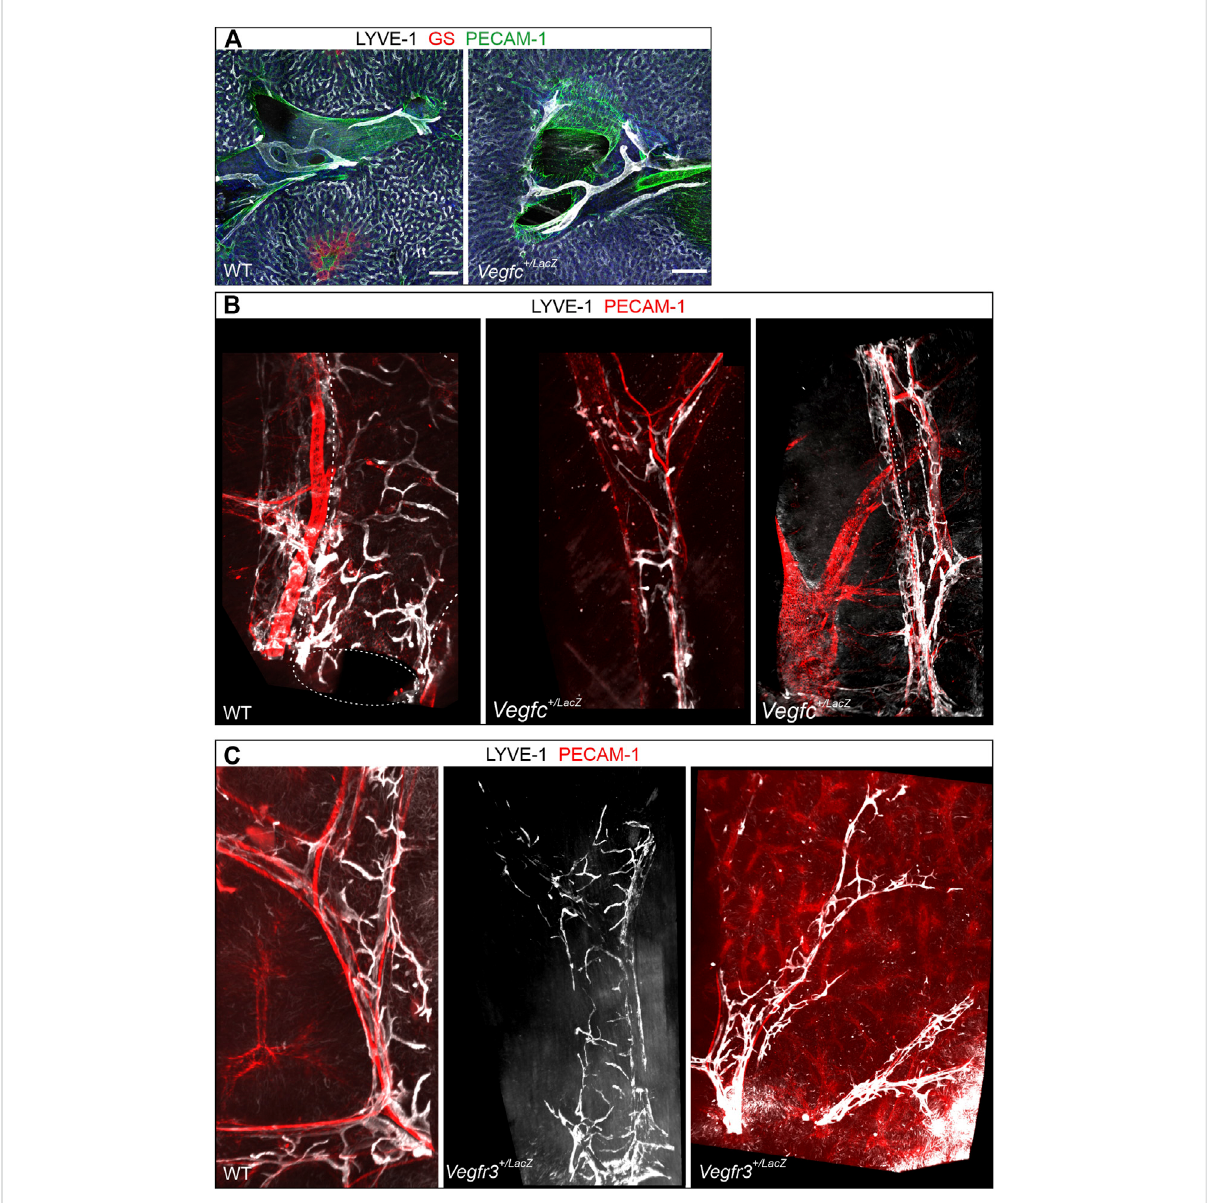
FIGURE 7 Importance of the VEGF-C/VEGFR-3 signaling axis for hepatic lymph vessel development. (A) : Vibratome sections (300 µm) of Vegfc +/LacZ and wildtype controls revealed no obviously discernible changes in lymphatic vessel structure at portal tracts (shown are branching points of the portal vein).Scalebar=100 µm. (B) :Incontrast,volumetricimagingofwholemountpreparationsreadilyidenti fi edrari fi edlymphaticbranchesclaspingthe portal vein and a disturbed overall spatial lymph vessel architecture. Diameter of portal tract = approximately 400 µm ( fi rst and second panel) and 200 µm (third panel). (C) : In contrast, in Vegfr3 +/LacZ mice the architecture of perpendicularly and longitudinally oriented lymph vessel branches around the portal veins was maintained however the vessel network was more sparse. Diameter of portal tract = approximately 300 µm ( fi rst and second panel) and 150 µm (third